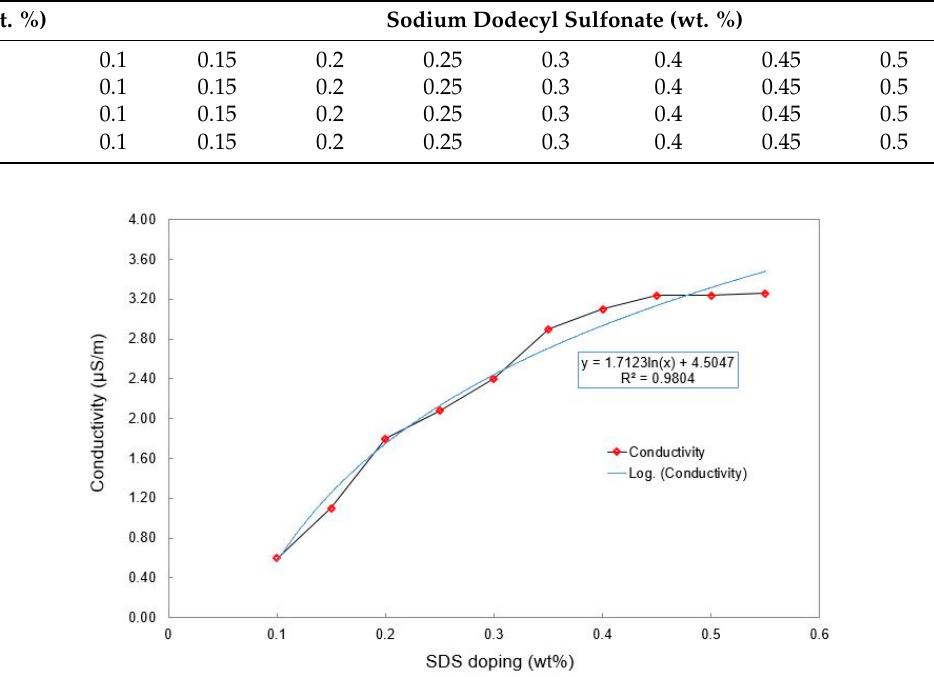
Figure 2. Change in the electrical conductivity with SDS doping at a fixed CNT wt. %.